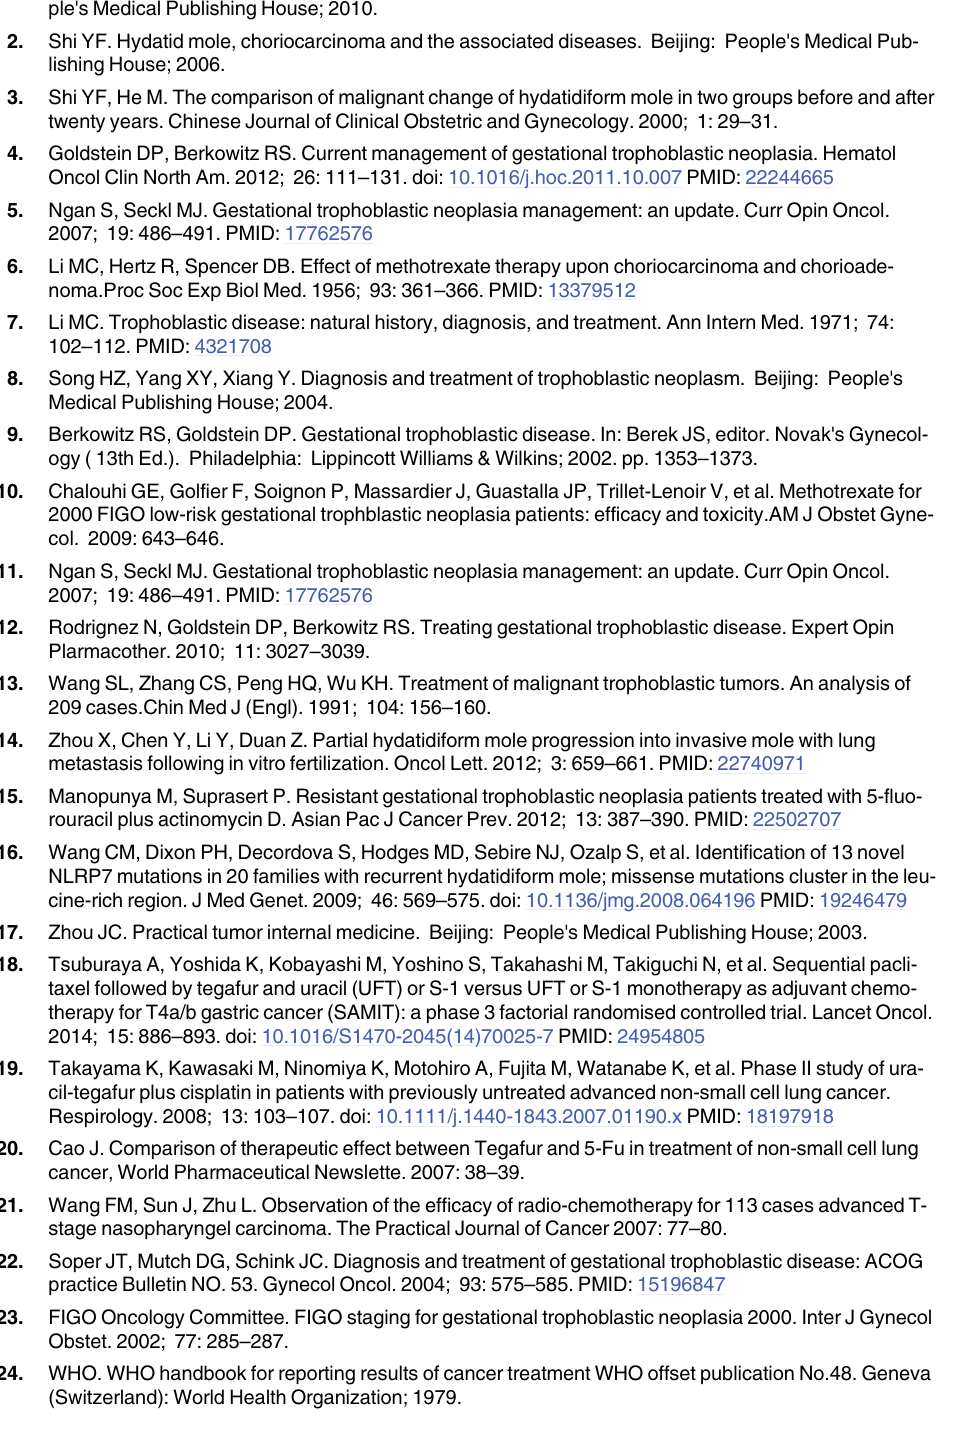
23. FIGO Oncology Committee. FIGO staging for gestational trophoblastic neoplasia 2000. Inter J Gynecol Obstet. 2002; 77: 285 – 287. 24. WHO. WHO handbook for reporting results of cancer treatment WHO offset publication No.48. Geneva (Switzerland): World Health Organization;